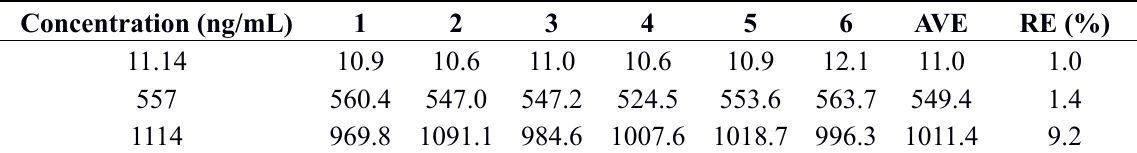
Table 10. Stabilities of three of freeze-thaw cycles ( n = 6).